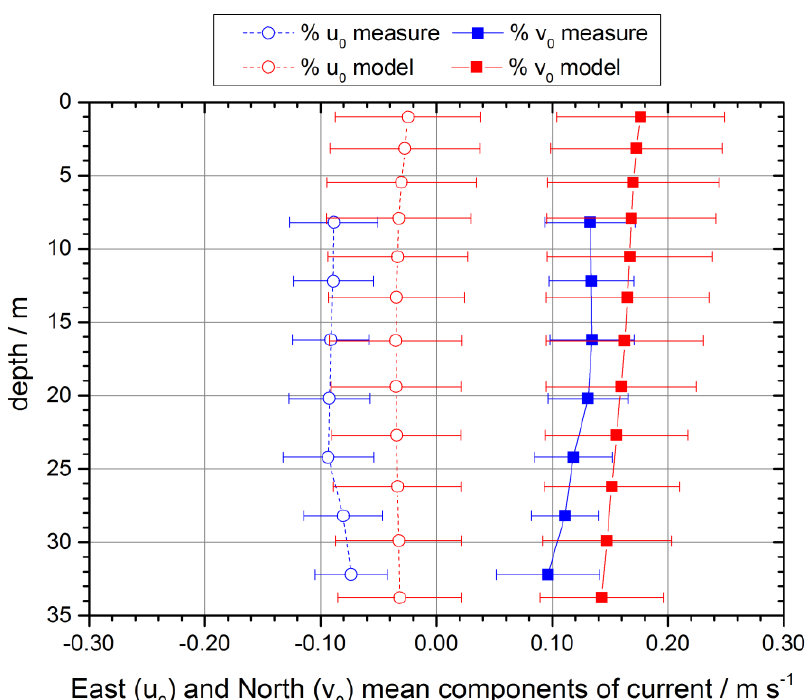
Figure 16. East and north components of monthly average current profiles, associated respectively with the experimental measurements (in blue) and the data provided by the model (in red).